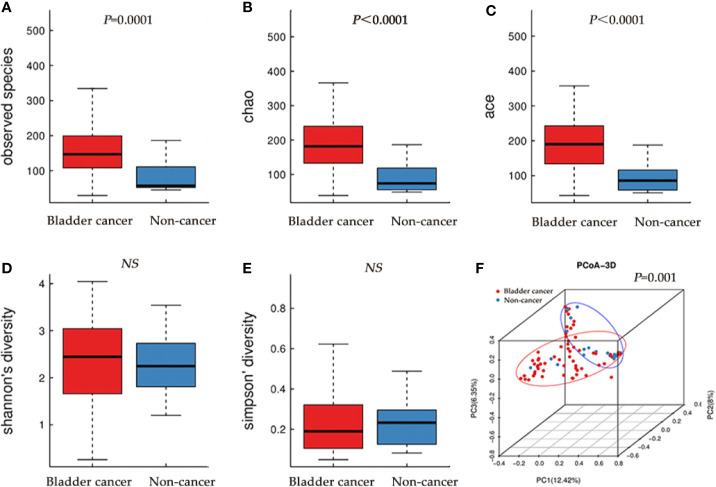
Alpha and principal coordinate analysis (PCoA) for bladder-cancer samples and non-cancer samples. (A–E) Box-plot showing alpha diversity in samples using different metrics (A, observed species index; B, Chao index; C, Ace index; D, Shannon index; E, Simpson index). (F) PCoA plots of unweighed UniFrac distances in which samples were colored by clinical outcome. The PERMANOVA performed on the Bray-Curtis distances showed that the observed differences were statistically significant (999 permutations; F = 2.71; P = 0.001).